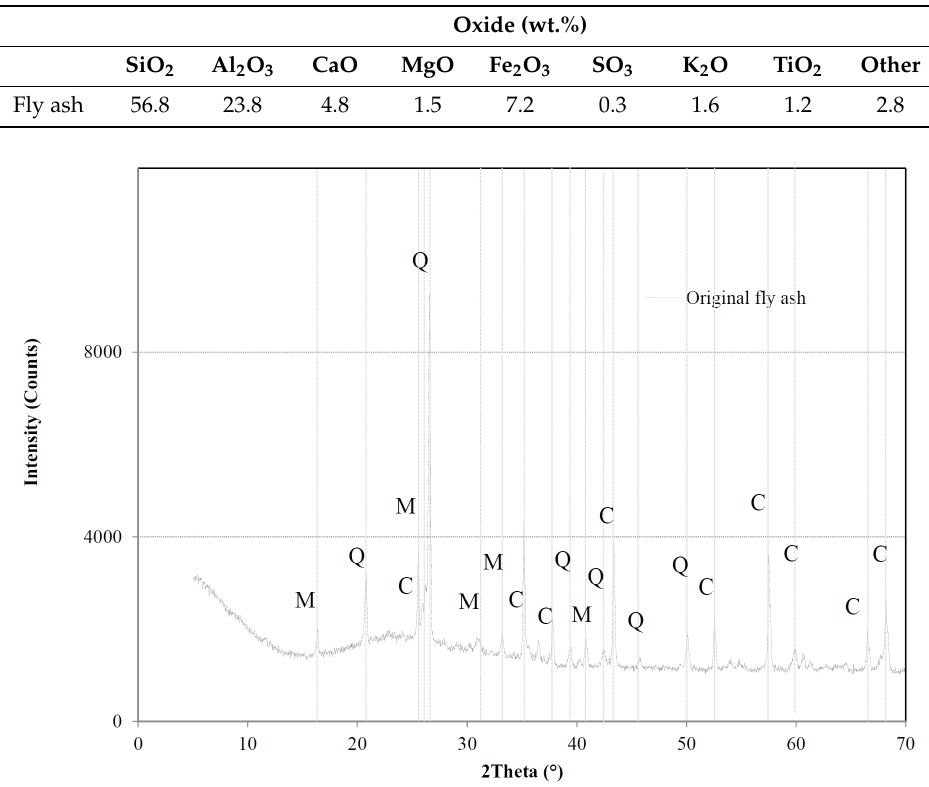
Figure 1. X-ray di ff raction analysis of the fly ash, Q = quartz (SiO 2 ); M = mullite (Al 4.8 O 9.54 Si 1.2 ) and Figure 1. Remotely delivered vs. in-person mental health care at the Nova Scotia Operational Stress C = Corundum ( α -Al 2 O 3 Injury Clinic (NSOSIC) (appointments / sessions per week).